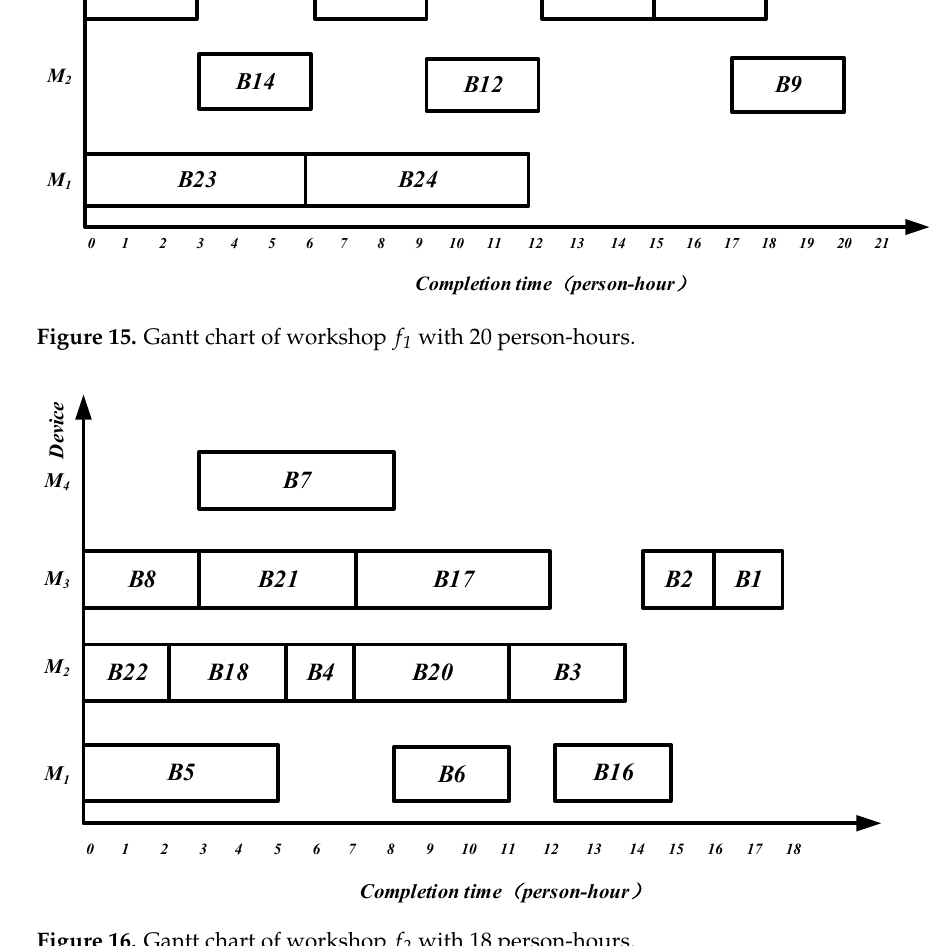
Figure 16. Gantt chart of workshop f